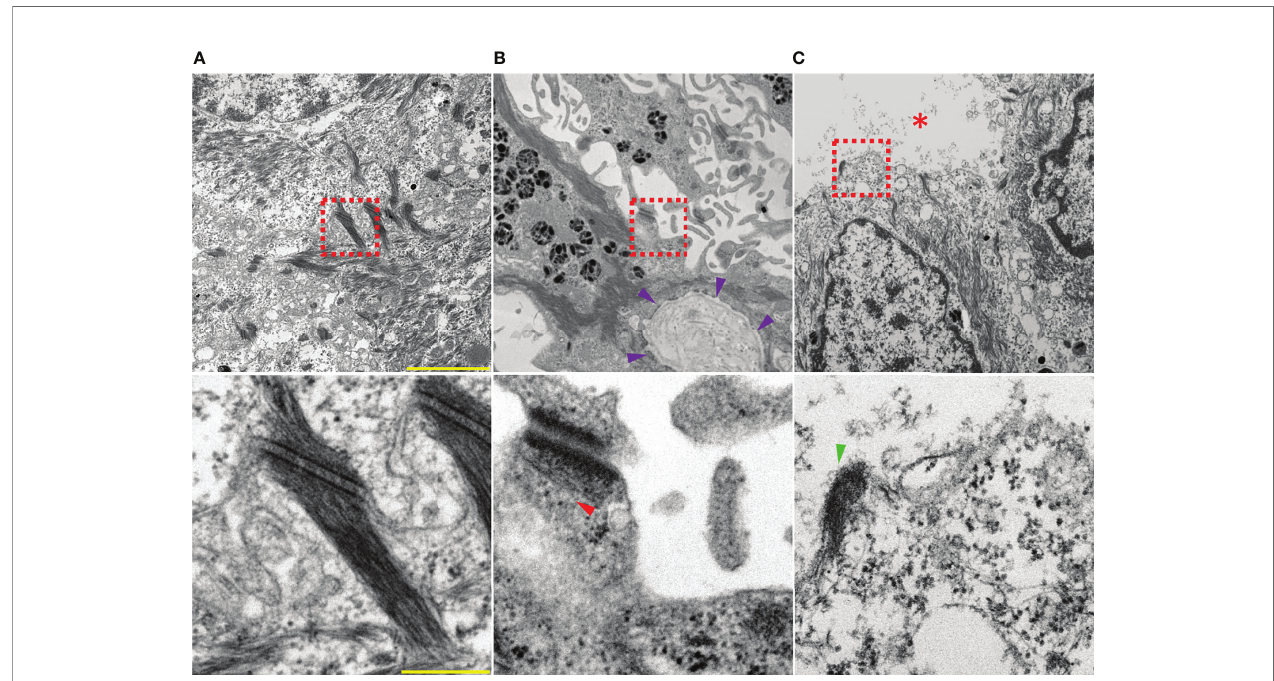
FIGURE 2 | Electron micrographs showing an overview (top) and zoomed in to a single desmosome (bottom) of (A) healthy skin injected with IgG from healthy volunteers. (B, C) skin injected with PV-IgG showing suprabasal blistering, interdesmosomal widening and altered desmosomes: (B) reduced keratin insertion (red arrow head) into a damaged plaque. Note that the distinction between the outer and inner desmosomal plaque is lost after incubation with PV-IgG; violet arrow heads indicate the basement membrane, (C) a split desmosome with half plaque (green arrow head), red asterisk indicates blister cavity. Scale bars: 2 µm (top) and 250 nm